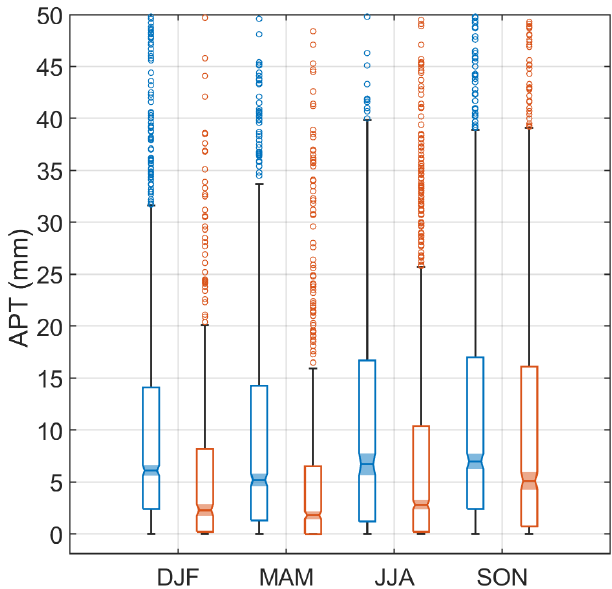
Figure 5. Box notch plot for each season comparing accumulated precipitation along trajectories (APT) for Clusters 1 (blue) and 2 (orange) from Fig. 4b. APT values were estimated from 4d HYS- PLIT back trajectories reaching Bermuda (32.30 ◦ N, 64.77 ◦ W) at 100ma.g.l. The middle, bottom, and top lines in each box represent the median, 25th percentile, and 75th percentile, respectively. Mark- ers show extreme values identified based on 1.5 × IQR (interquartile range) distance from the top of each box. Whiskers represent max- imum and minimum values excluding extreme points. Boxes with notches and shaded regions that do not overlap have different medi- ans at the 95% confidence